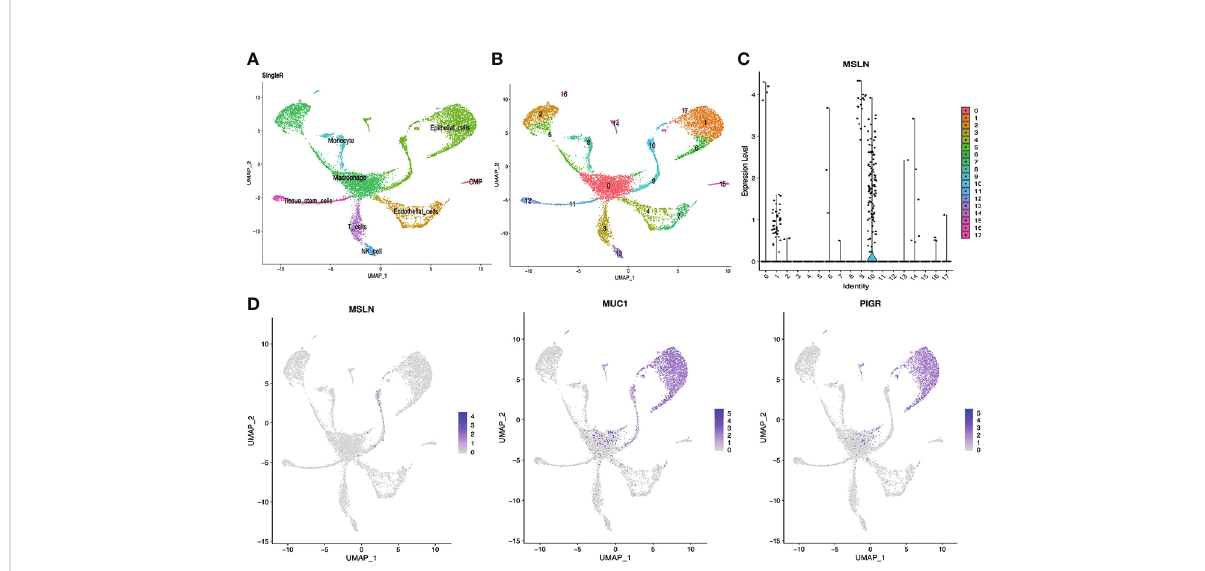
FIGURE 2 scRNA-seq data analysis of lung showing pulmonary cells with high MSLN expression. (A) Cell types in the lung according to SingleR. (B) Cells in the lung were categorized into 18 different clusters, numbered 0 to 17. (C) Violin plot of MSLN expression distribution in these 18 different cell clusters. (D) Scatter plots showing thagt the cluster of cells with high expression of MSLN also expressed the typical pulmonary cells markers MUC1 and